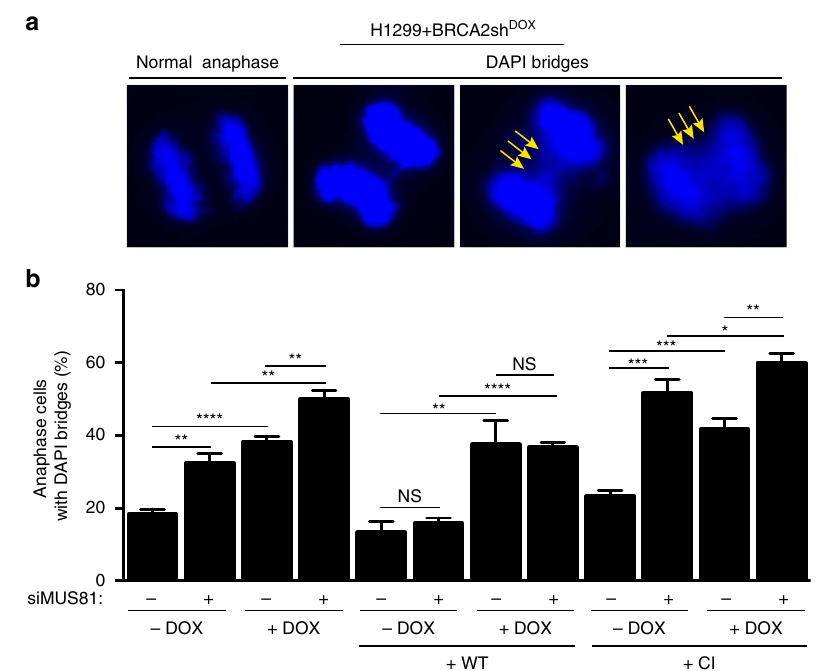
Figure 3 | MUS81 resolves mitotic chromosome interlinks in BRCA2-deficient cells. ( a ) H1299 cells carrying a DOX-inducible BRCA2 shRNA were transfected with control or MUS81 siRNAs and processed 72h later for anaphase bridge analysis. Stable cells lines expressing either WT or CI human MUS81 were similarly processed. Representative images of DAPI-stained anaphase cells are shown. Yellow arrows indicate multiple DAPI bridges. ( b ) Quantification of the frequency of anaphase cells containing multiple DAPI bridges. Error bars represent s.d. ( n ¼ 3). * P o 0.05; ** P o 0.01; *** P o 0.001; **** P o 0.0001 (unpaired two-tailed t